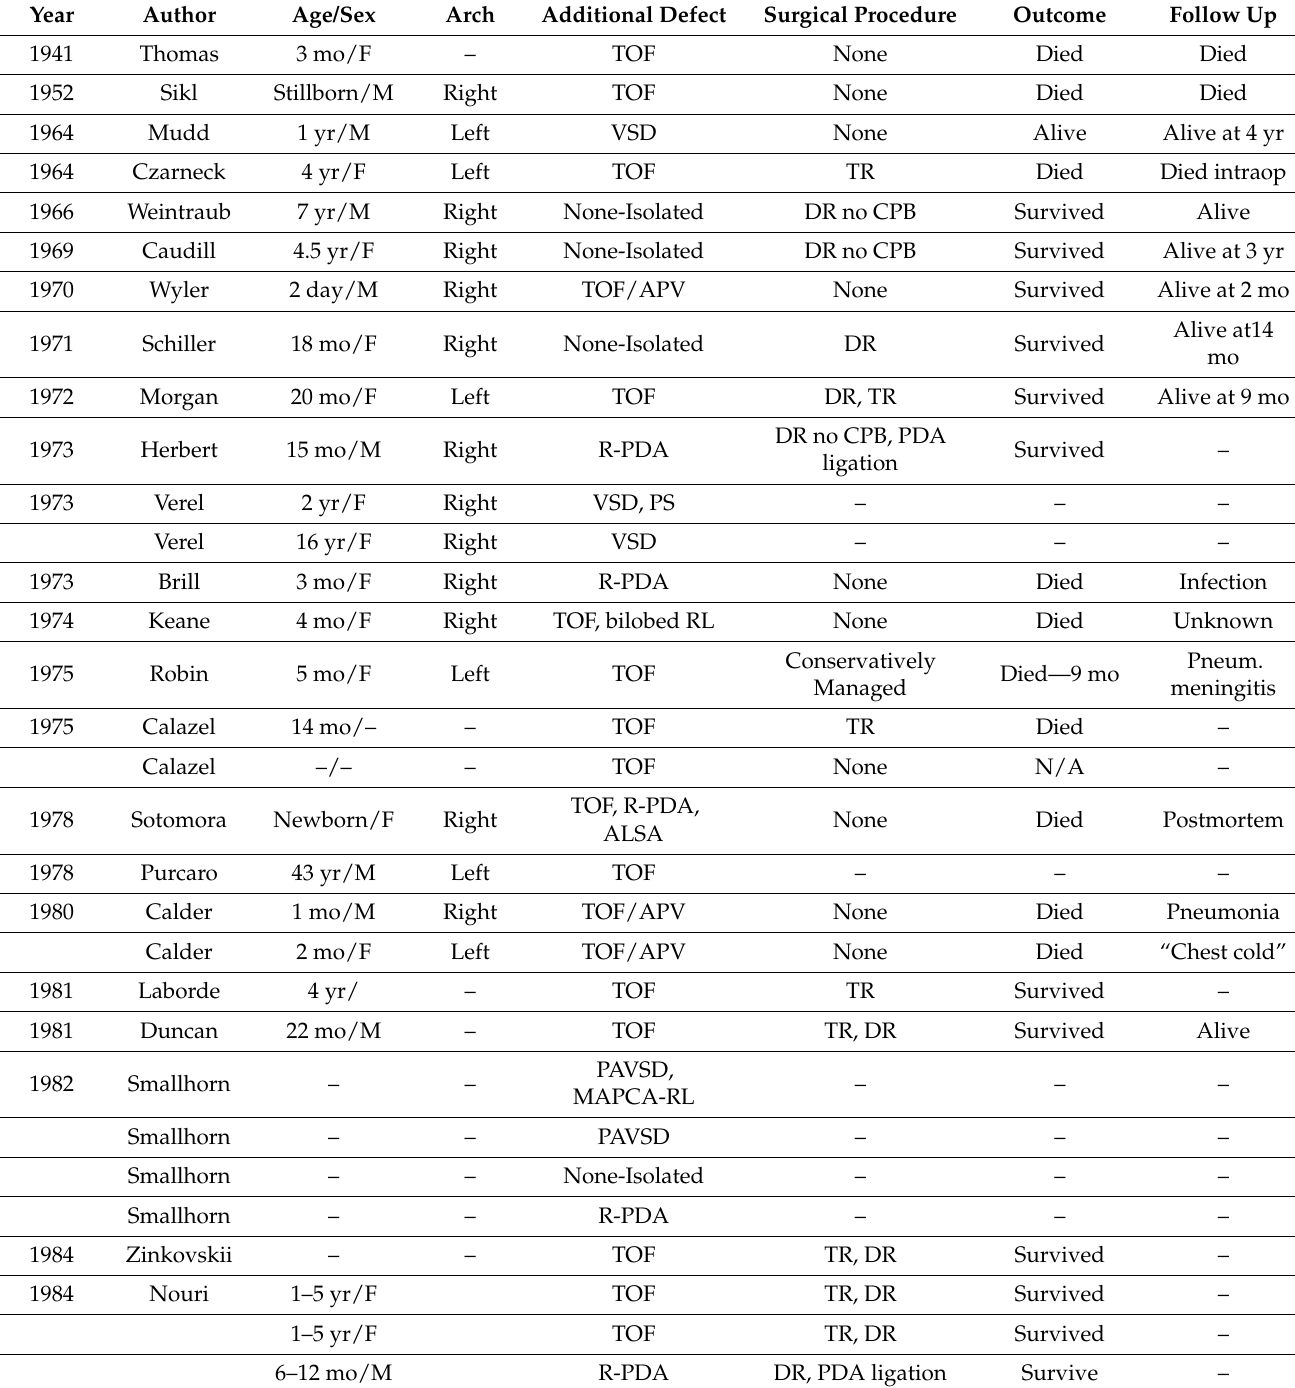
Table 1. Cases reported in the literature. AR(L)SA = Aberrant Right (Left) Subclavian Artery, CPB = Cardiopulmonary Bypass, DR = Direct reimplantation, DORV = Double Outlet Right Ventricle, MOF = Multi-organ failure, PAVSD = Pulmonary atresia ventricular septal defect, PLSVC = Persistent left superior vena cava, PVOD = Pulmonary Vascular Obstructive Disease, PVR = Pulmonary Valve replacement, MAPCA-RL= major aortopulmonary collateral vessels supplying the right lung, RL = Right lung, R-PDA= Right Patent Ductus Arteriosus, TOF = Tetralogy of Fallot, TR = Tetralogy of Fallot repair, VSD = Ventricular Septal Defect, * reported in Tagliente and Prifiti—no citation found [21,23]. Dy = days, mo = months, yr = years, wk = weeks, N/A = not